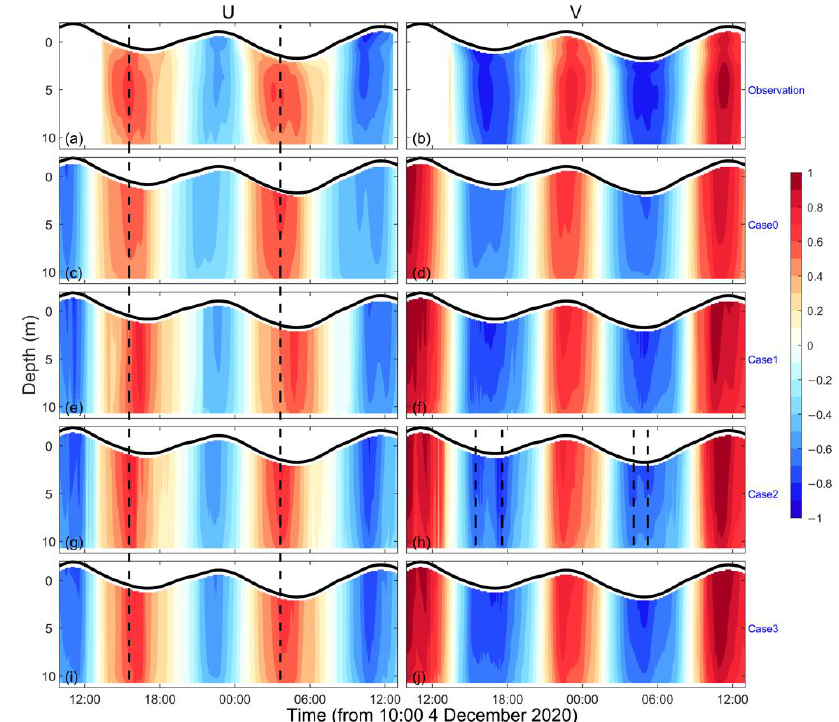
Figure 6. Time series of eastward (left) and northward (right) velocities for ( a , b ) observation data, ( c , d ) Case0, ( e , f ) Case1, ( g , h ) Case2, and ( i , j ) Case 3 at C10 (in m/s). Thick black lines indicate sea level variations (in m).